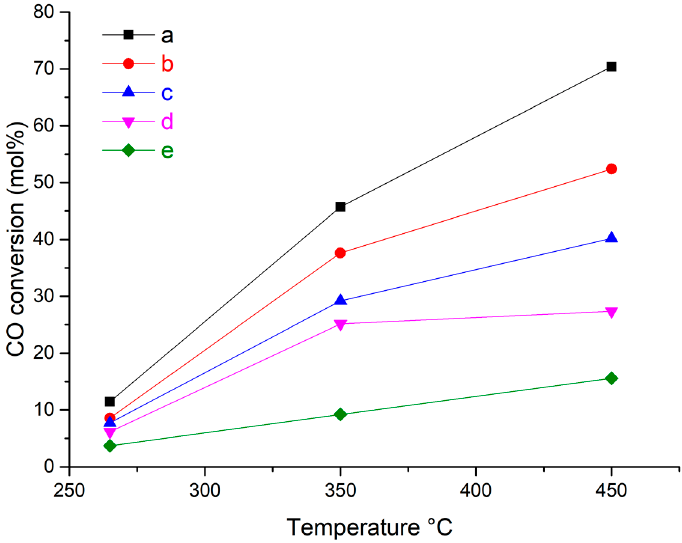
Figure 3. Laboratory test of CO conversion achieved by CATs served in industry for different years: